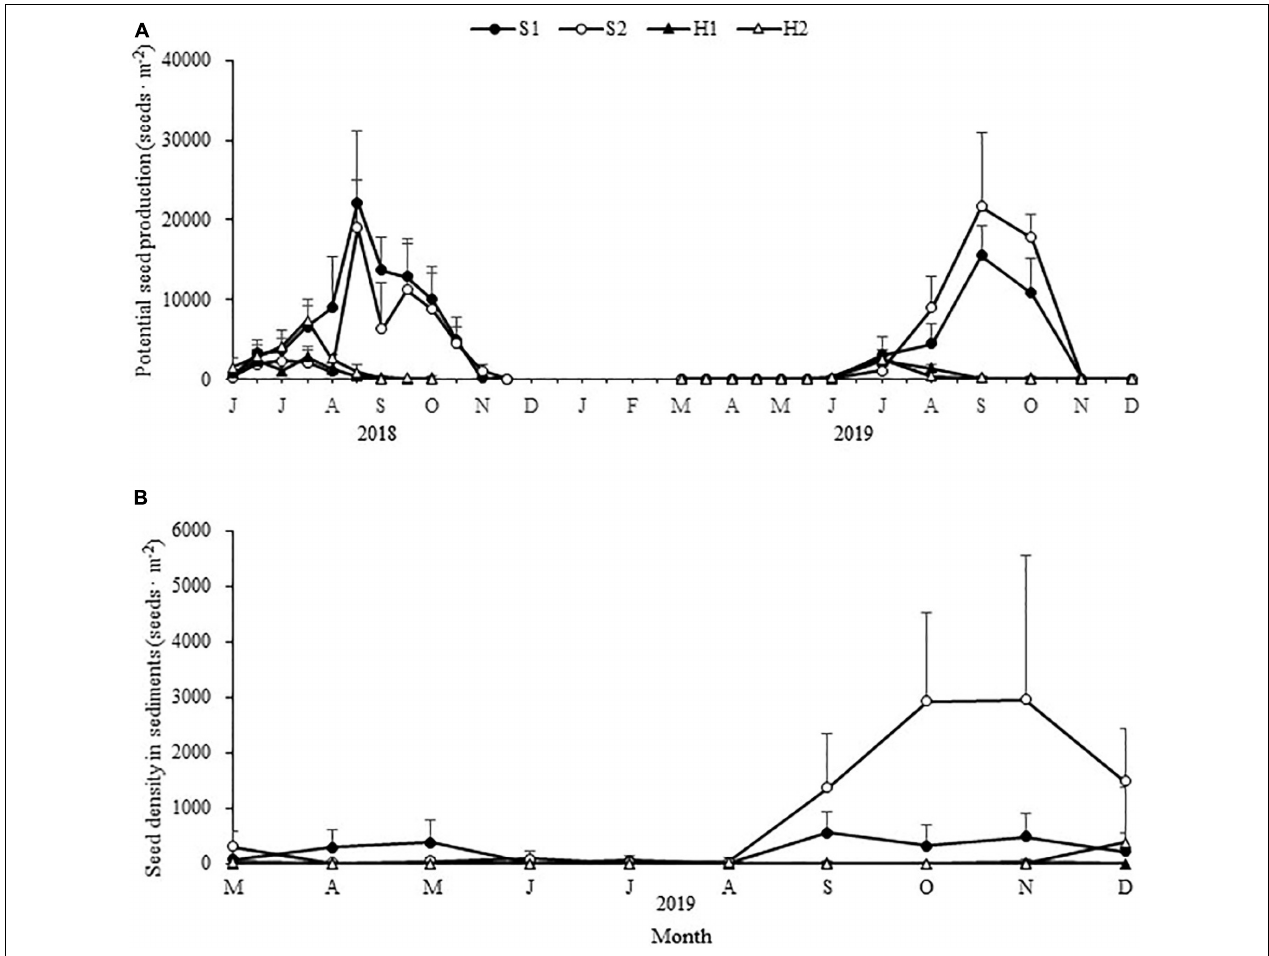
FIGURE 9 | Seasonal changes in potential Zostera japonica seed production (A) and seed density in sediments (B) at the four study sites from June 2018 to December 2019. Values are mean ± SD ( N = 7 cores per site). TABLE 3 | Maximum potential seed production and maximum seed density in sediment of Zostera japonica at the four study sites from March 2019 to December 2019. Variable S1 S2 H1 H2 Maximum potential seed production (seeds · m − 2 ) Maximum seed density in